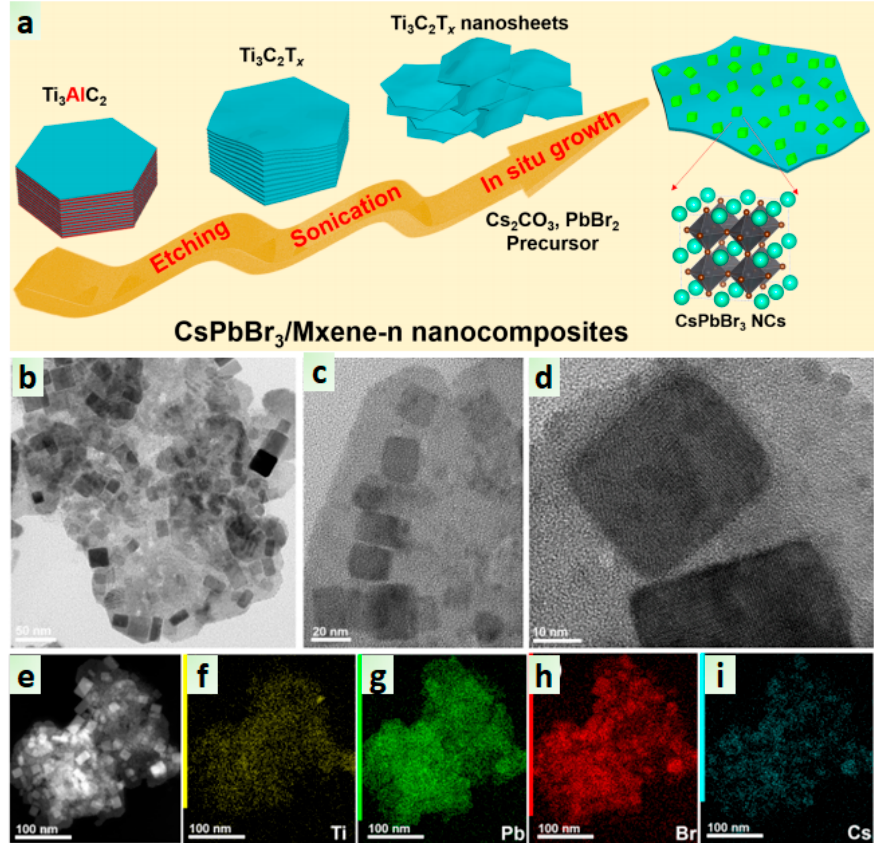
Figure 4. ( a ) An in − situ synthetic procedure for CsPbBr 3 /MXene, ( b − d ) TEM and HR-TEM images of CsPbBr 3 /MXene-20 composite and ( e − i ) EDX elemental mapping for the respective elements. Reproduced from [77], with permission from American Chemical Society, 2019.